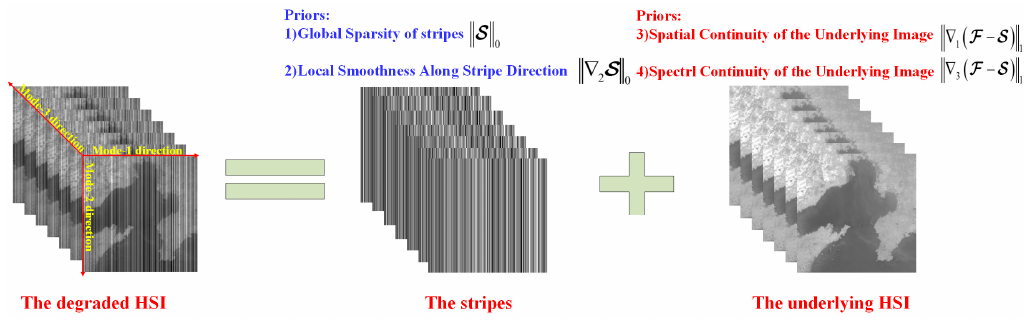
Figure 1. The framework of the proposed method.